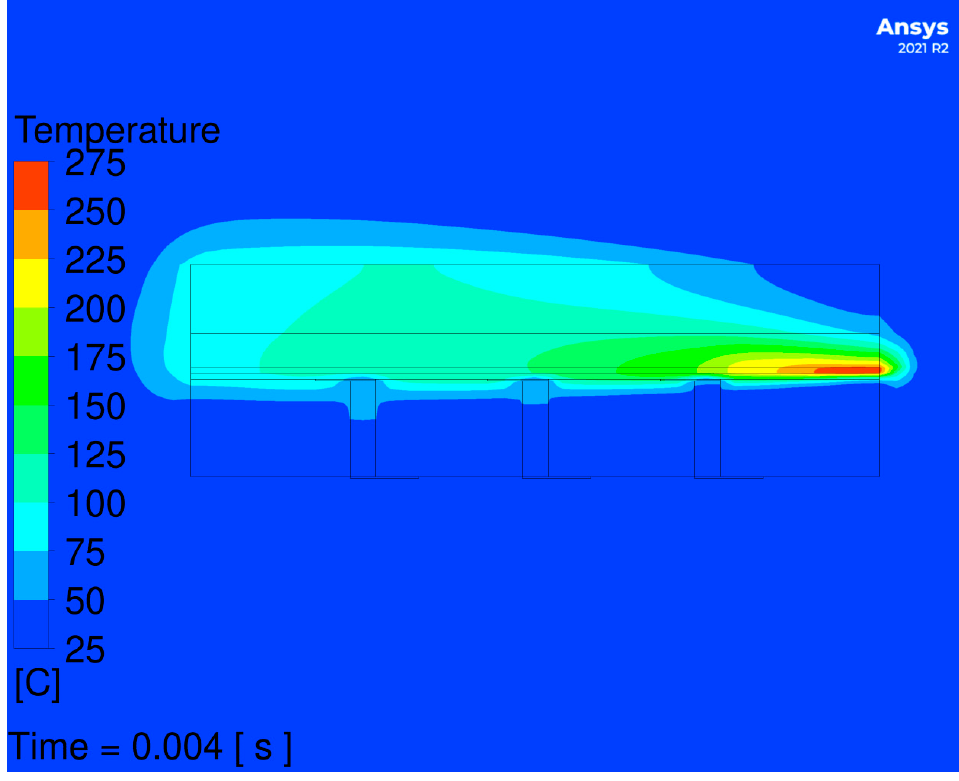
Figure 11. Temperature contours after 4 ms.